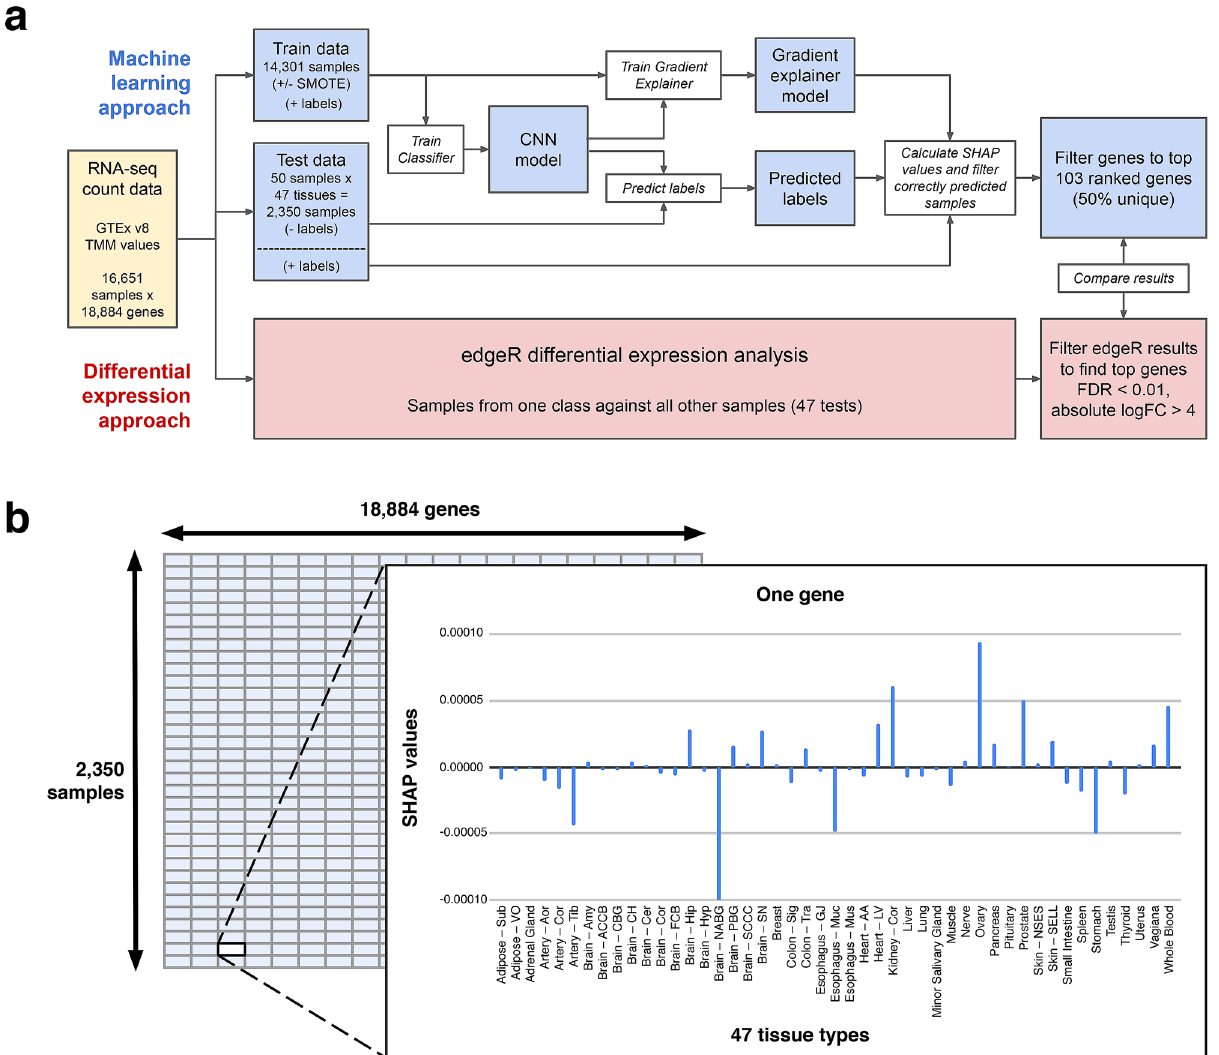
Figure 1. Study overview. ( a ) Genotype-Tissue Expression (GTEx) RNA-seq data were analysed in parallel using an ML approach to generate SHapley Additive exPlanation (SHAP) values (blue), and using a differential expression analysis approach (red). ( b ) Schematic showing the shape of SHAP output for held-out test data. Matrix of 18,884 genes × 2350 samples, where each cell contains values for each tissue type making the matrix 18,884 × 2350 × 47. The inner schematic shows SHAP values that represent the contribution of the gene to the prediction, where positive SHAP values indicate a positive effect on the model’s confidence in the tissue type label, and negative SHAP values indicate a negative effect. When filtering SHAP values, only the SHAP value corresponding to the correct tissue type was selected and the remaining values were omitted, making the final matrix 18,884 × 2,350. CNN: Convolutional Neural Network; FDR: False Discovery Rate; logFC: log2 Fold Change ; SMOTE: Synthetic Minority Over-sampling Technique; TMM: Trimmed Mean of